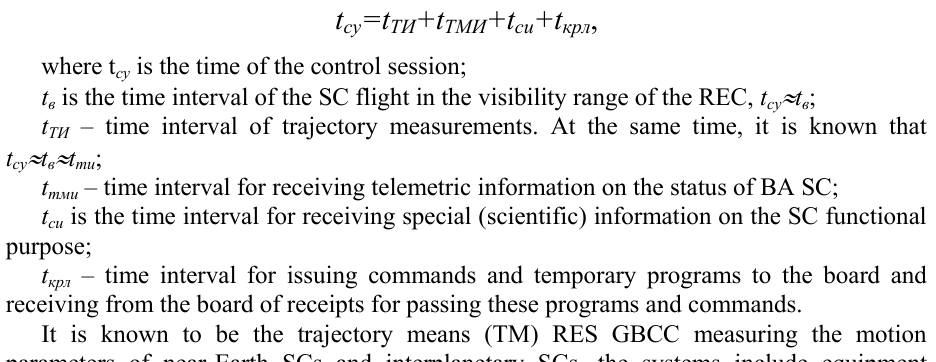
Fig. 1. Dependence of the height of the orbits of the identifying SC for ground-based antenna systems with different effective area, where 1 is an antenna complex with Ae = 2500 m 2 ; 2 – antenna complex with Ae = 1000 m 2 ; 3 – antenna complex with Ae = 400 m 2